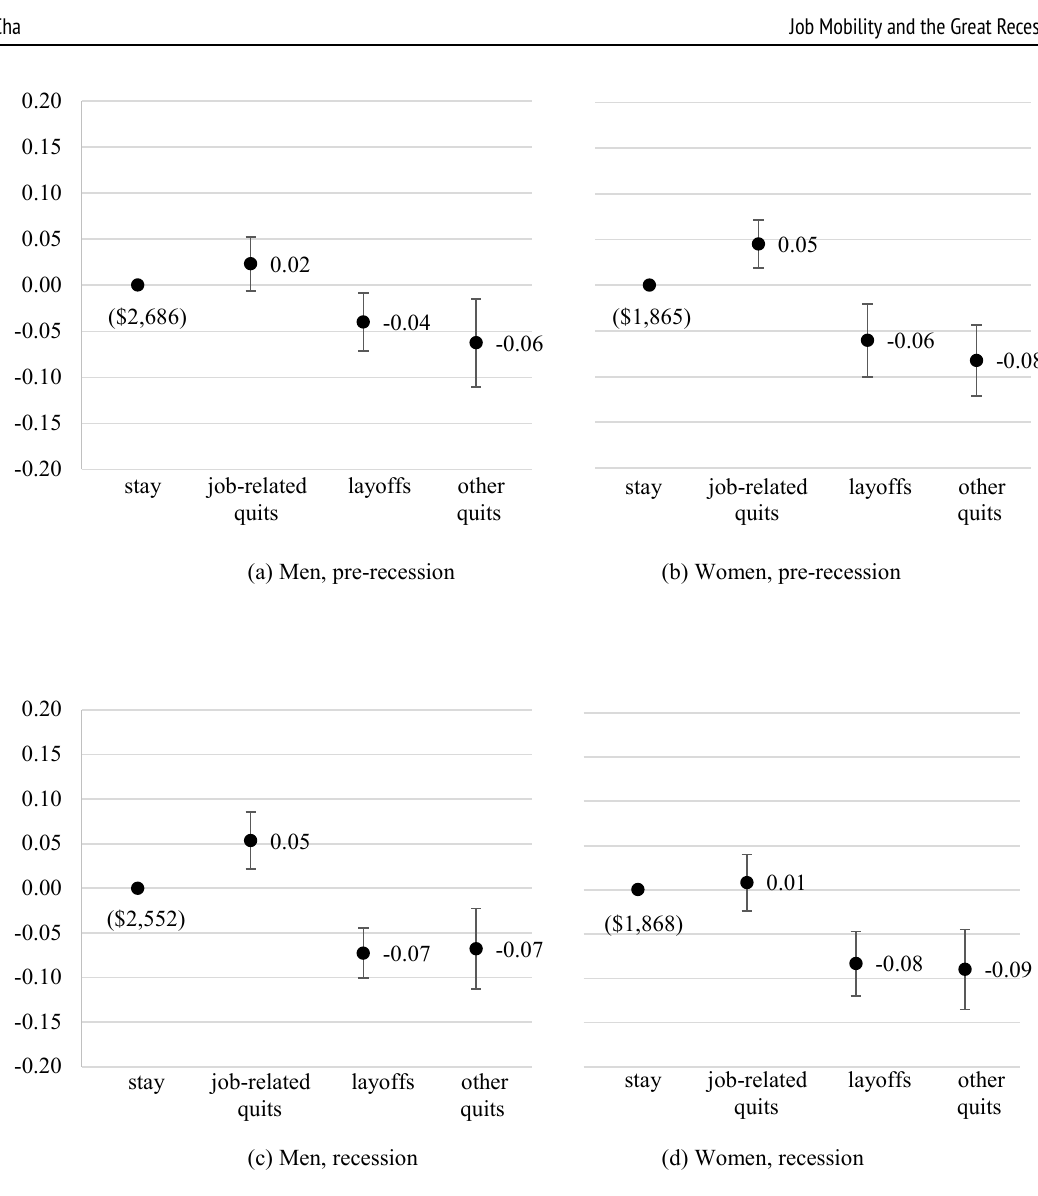
Figure 2: Differences in logged monthly earnings between childless stayers and job